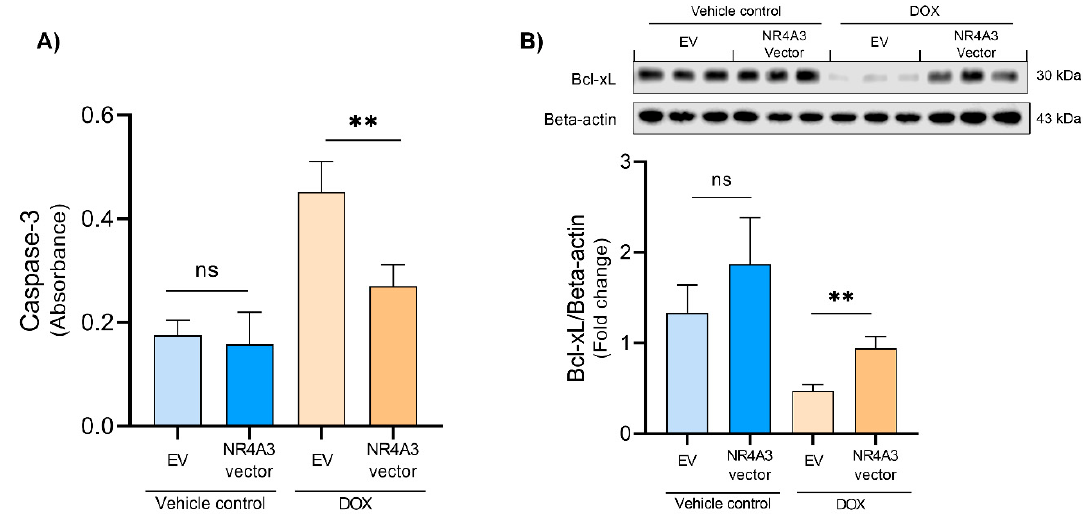
Figure 3. Effect of NOR-1 overexpression on caspase-3 activity and Bcl-xL expression in DOX-treated CMs. ( A ) CMs were transfected with vectors encoding NR4A3 or the corresponding empty vector before treatment with 5 µ M of DOX for 12 h. Caspase-3 activity assay was performed after treatment to determine the amount of apoptosis in each group. Absorbance was measured at 405 nm. Each treatment group consisted of four biological replicates and the caspase-3 activity assay was performed on three technical replicates from each biological replicate. ( B ) Western blot showing NOR-1 attenuating the effect DOX treatment on the expression of Bcl-xL normalized to loading control Beta-actin ( N = 3). The graphs in ( A ) and ( B ) are presented with mean ± SD. ns = p > 0.05 (not significant), ** = p ≤ 0.01.